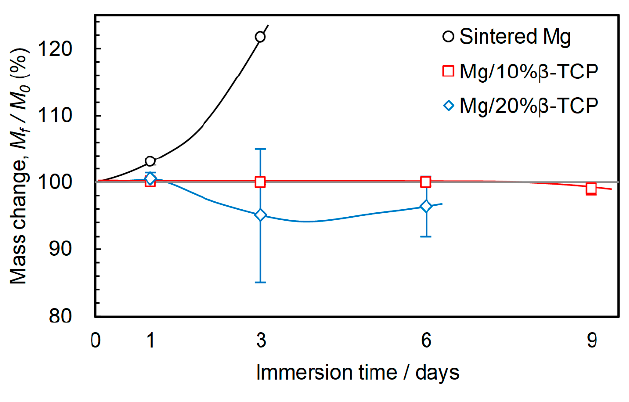
Figure 8. Mass change after immersion for prescribed periods. Figure 9A,B show changes in the maximum compressive stress and 0.2% yield stress as the immersion period increased. Before immersion, the Mg/ β -TCP composites showed considerably enhanced initial strength compared with the sintered Mg. The Mg/20% β - TCP exhibited a maximum compressive strength two times higher and 0.2% yield strength four times higher than those of the sintered